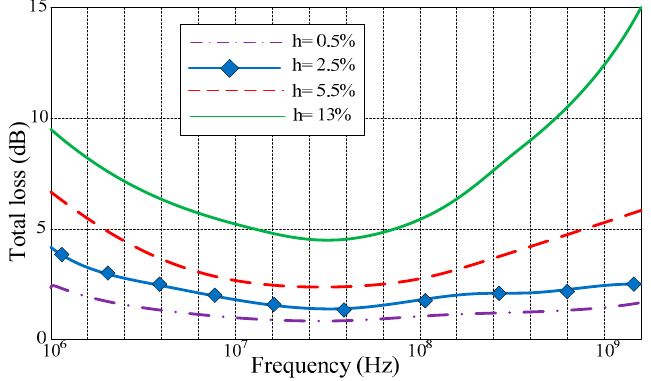
Figure 3. Total loss of electromagnetic waves penetrating concrete.